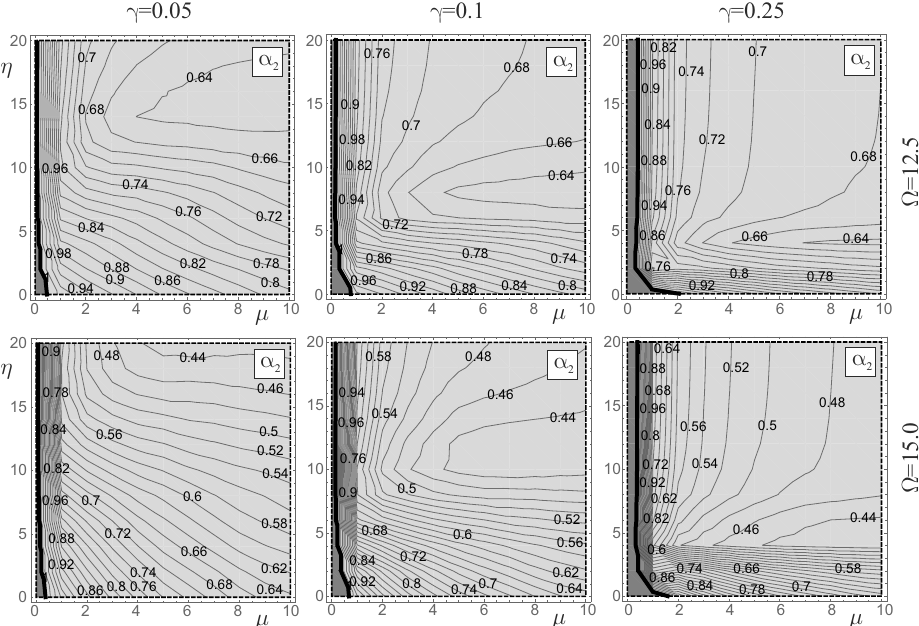
Figure 7. Gain α 2 maps for different mass ratios γ of the yielding system and different frequencies Ω of the harmonic excitation ( ψ = 0.1, A s = 0.7 g m/s 2